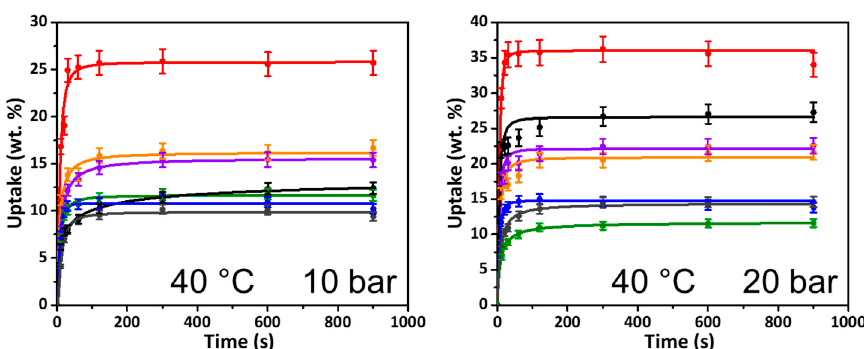
Figure 4. Kinetic studies of CO 2 uptake, for poly(styrene), triphenylmethanol, BINOL, carbazole, triphenylamine, dibenzyl ether and fluorobenzene networks at 40 °C and 10 bar ( left ) and 20 bar ( right ).